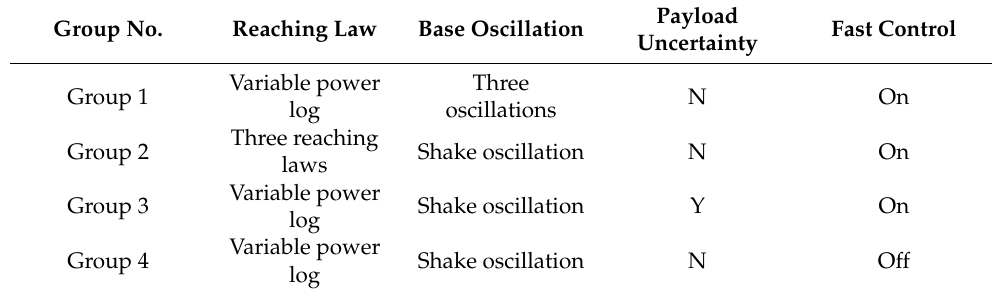
Table 2. Simulation experiment groups.